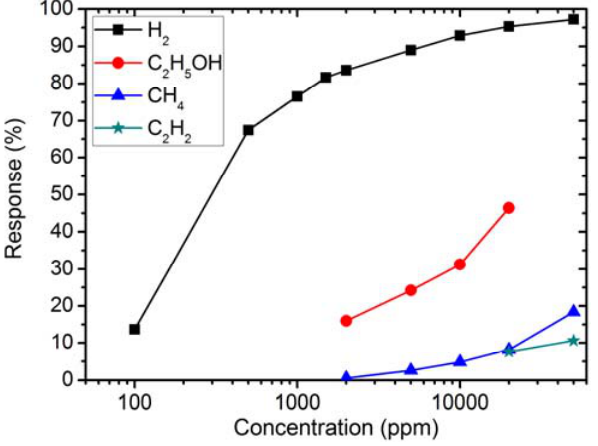
Figure 7. Sensing response of MWCNT-doped WO of 350 °C to various concentrations of different gas